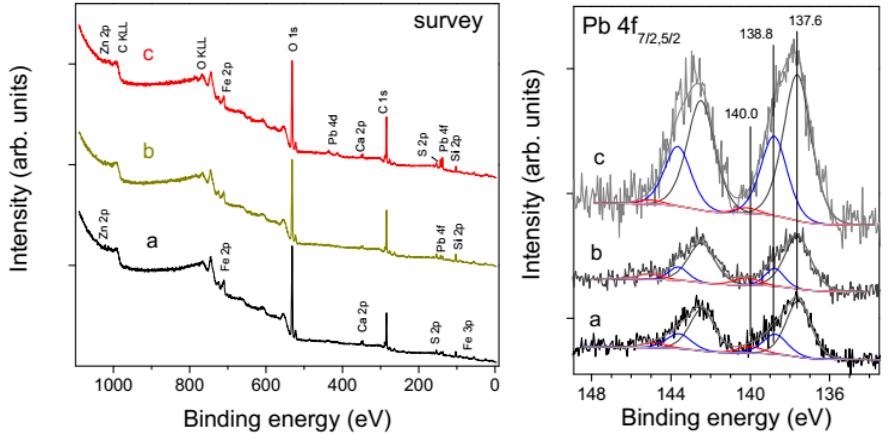
Figure 7. Photoelectron survey and Pb 4f spectra from ( a ) ground Pb-Zn sulfide ore, ( b ) the ground ore treated with 0.1 M Na 2 S solution (10 min); ( c ) the ground ore treated with water heated to 60 °C (10